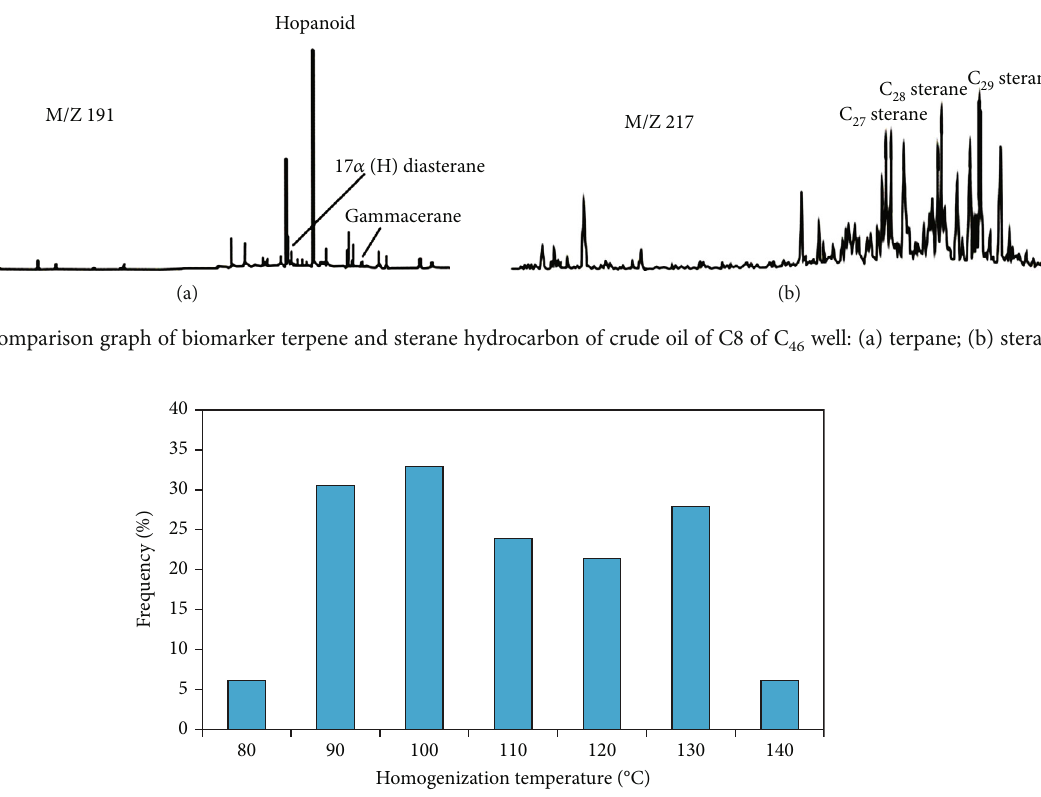
Figure 5: Histogram showing homogenization temperatures of fl uid inclusions of C8 in study